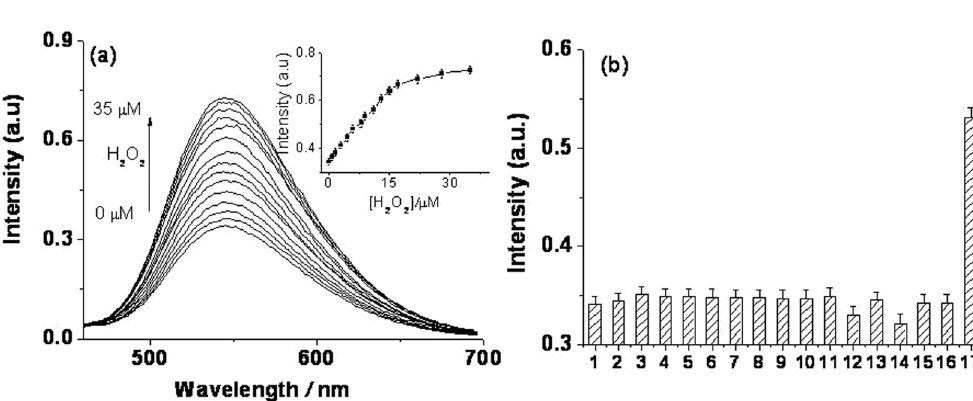
Figure 4. ( a ) Luminescence emission spectra of 1 μ M Ir-1 in Tris-HNO 3 buffer solution (pH 7.0) containing 2.8 μ M AgNPs and different concentrations of H 2 O 2 (0 μ M to 35 μ M). The inset is the luminescence intensity plotted against the H 2 O 2 concentration. ( b ) Luminescence intensity of the Ir-1 -AgNP system (0.3 μ M Ir-1 and 2.8 μ M AgNPs in Tris-HNO 3 at pH 7.0) in the presence of interfering species (HSA and BSA 50 μ g/L, other interfering species 50 μ M) or H 2 O 2 (9 μ M) (from 1 to 17: blank, threonine, serine, glycine, ascorbic acid, HSA, BSA, Zn 2 + , Co 2 + , Ni 2 + , Cd 2 + , Fe 3 + , Mg 2 + , Cu 2 + , K + , Na + , and H 2 O 2